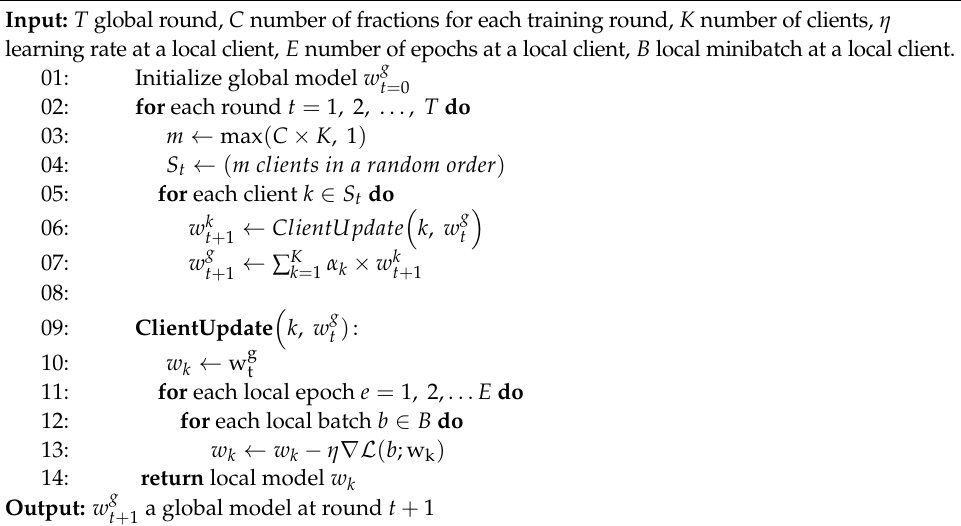
Algorithm 1 FL with Federated Averaging (FedAvg) algorithm